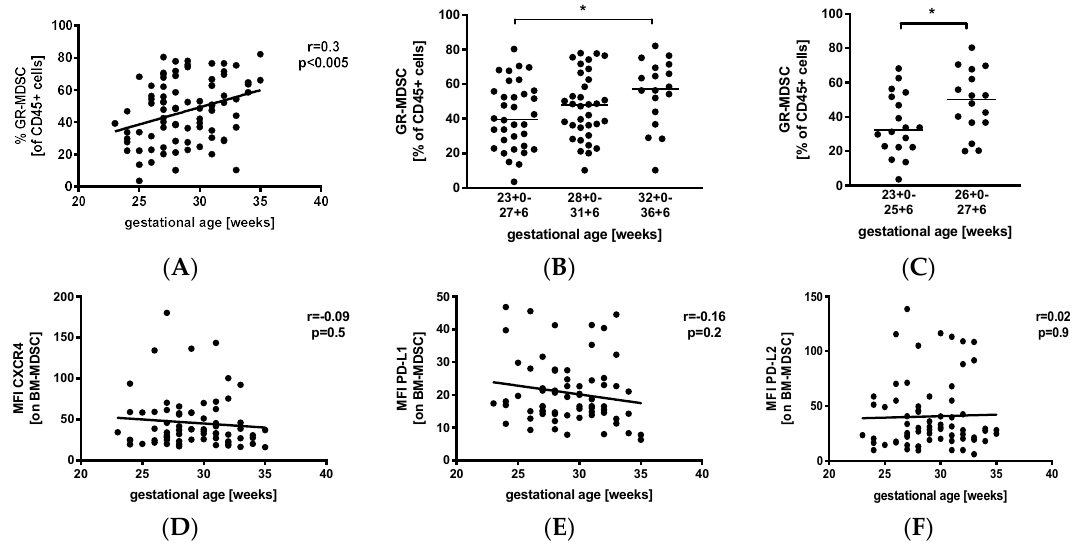
Figure 1. Quantification of granulocytic myeloid-derived suppressor cells (GR-MDSC) in the breast milk of preterm infants (dependency on gestational age). Milk cells were isolated from the breast milk of mothers of preterm infants during the first five weeks of life. Percentages of GR-MDSC (of total CD45 + leucocytes) and the expression of activation markers CXC-motif chemokine receptor 4 (CXCR4), programmed death ligand-1 (PD-L1), and programmed death ligand-2 (PD-L2) on breast milk containing a large population of GR-MDSC (BM-MDSC) were determined by flow cytometry. The mean percentages of BM-MDSC and the mean mean fluorescence intensity (MFI) of activation markers over the first five weeks were calculated. ( A ) Scatter diagram showing the percentage of GR-MDSC of total milk leucocytes depending on gestational age. Regression line shows the correlation between percentages of BM-MDSC and gestational age. n = 86, Spearman correlation. ( B ) Scatter diagram showing the percentage of GR-MDSC of milk leucocytes from mothers of preterm infants delivered at < 28 0 / 7 WOG, between 28 0 / 7 and 31 6 / 7 WOG and > 32 0 / 7 WOG. n = 18–34, * p < 0.05; Kruskal–Wallis test and Dunn’s multiple comparison test. ( C ) Scatter diagram showing the percentage of BM-MDSC from mothers of preterm infants delivered at < 26 0 / 7 WOG, between 26 0 / 7 and 27 6 / 7 WOG, * p < 0.05; Mann–Whitney test. ( D – F ) Scatter diagrams showing the expression of CXCR4 ( D ), PD-L1 ( E ) and PD-L2 ( F ) on BM-MDSC depending on gestational age. Regression line shows the correlation between percentages of BM-MDSC and postnatal age. n = 86, p > 0.05, Spearman